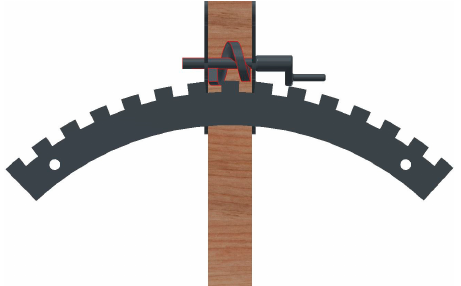
Figure 8 . Details of the gear between the worm screw and the quarter gear. Figure 8. Details of the gear between the worm screw and the quarter